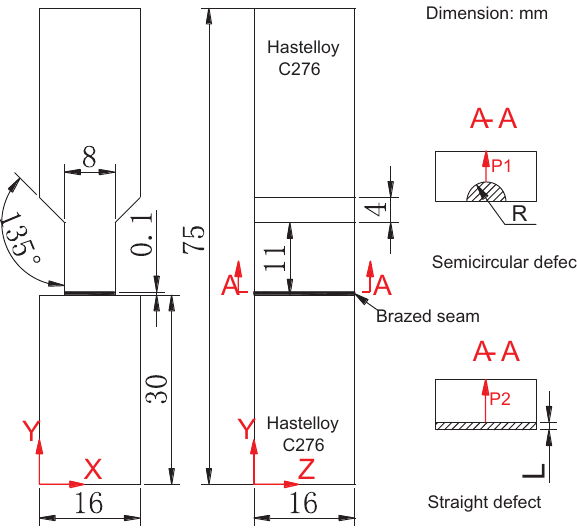
Figure 2: Geometry of brazed joint containing